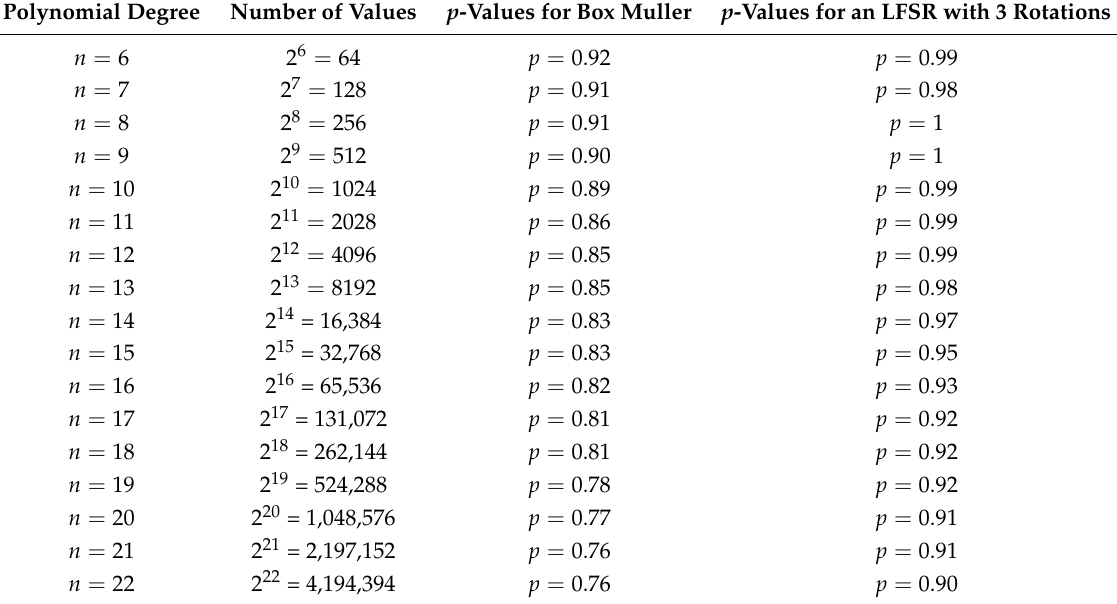
Table 4. Evolution of the p -values obtained, after applying the Chi Square Goodness of Fit Test method to a set of values, for Box-Muller and a 3 rotations LFSR